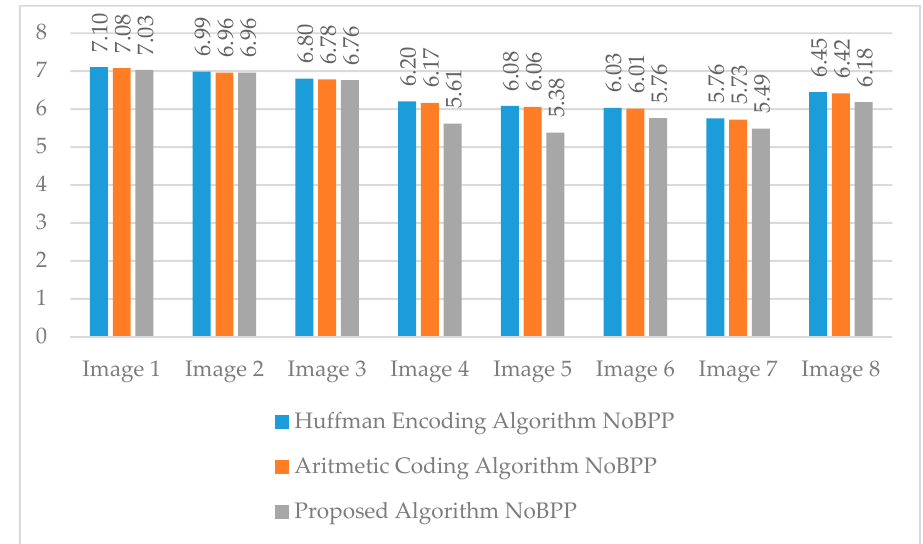
Figure 19. NoBPP values of Group 3 images.